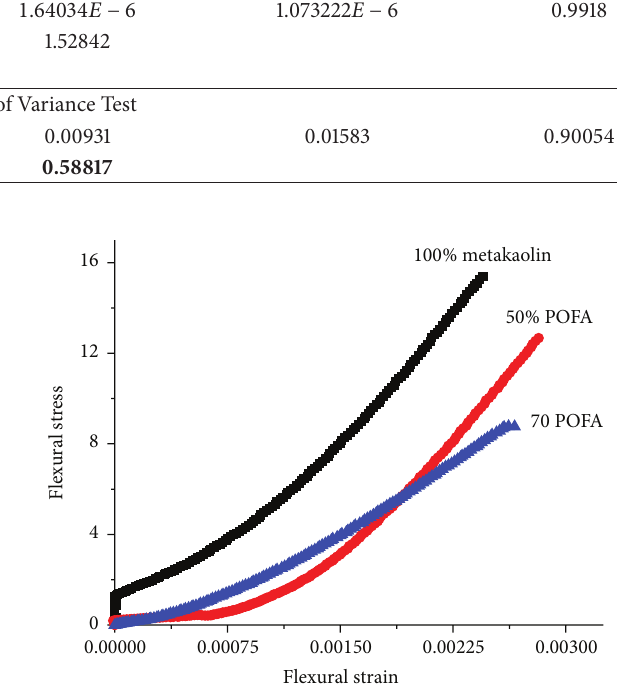
Figure 1: Influence of POFA on stress-strain behavior geopolymer